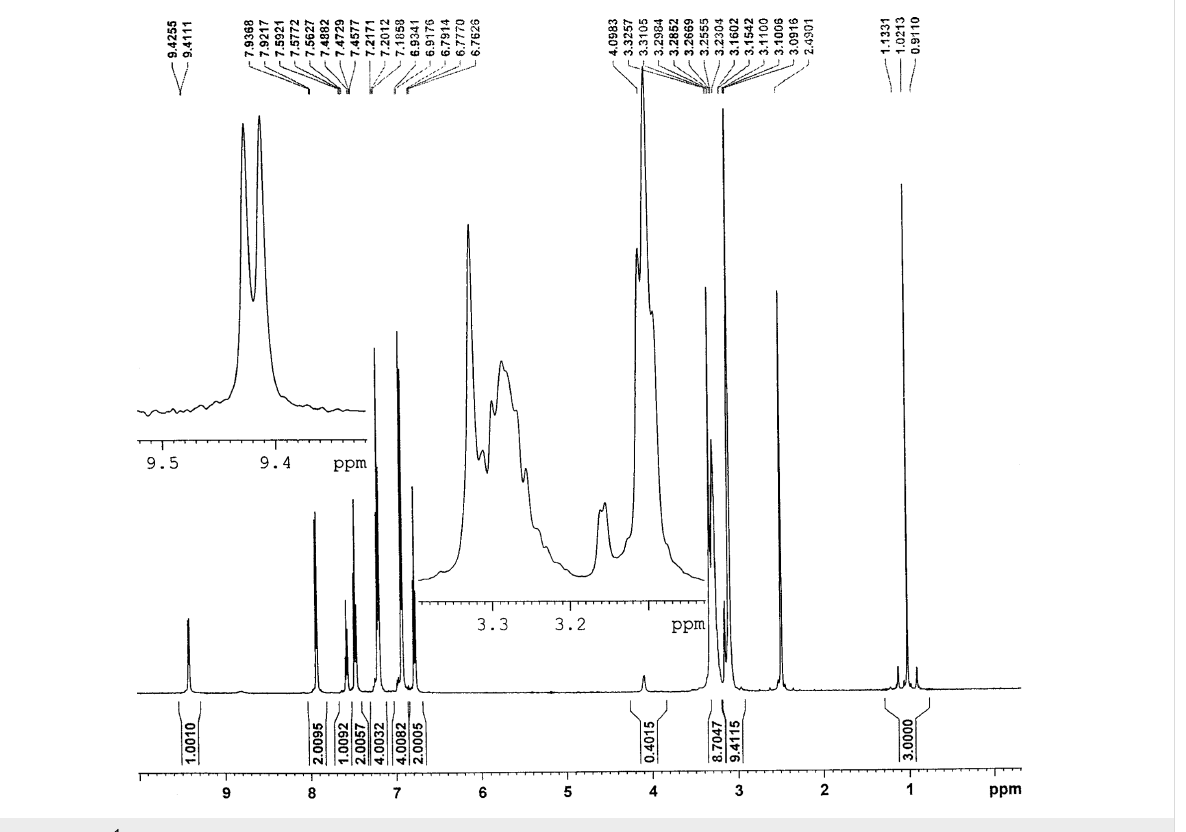
Figure 1: The 1 H NMR spectrum of compound 1 .